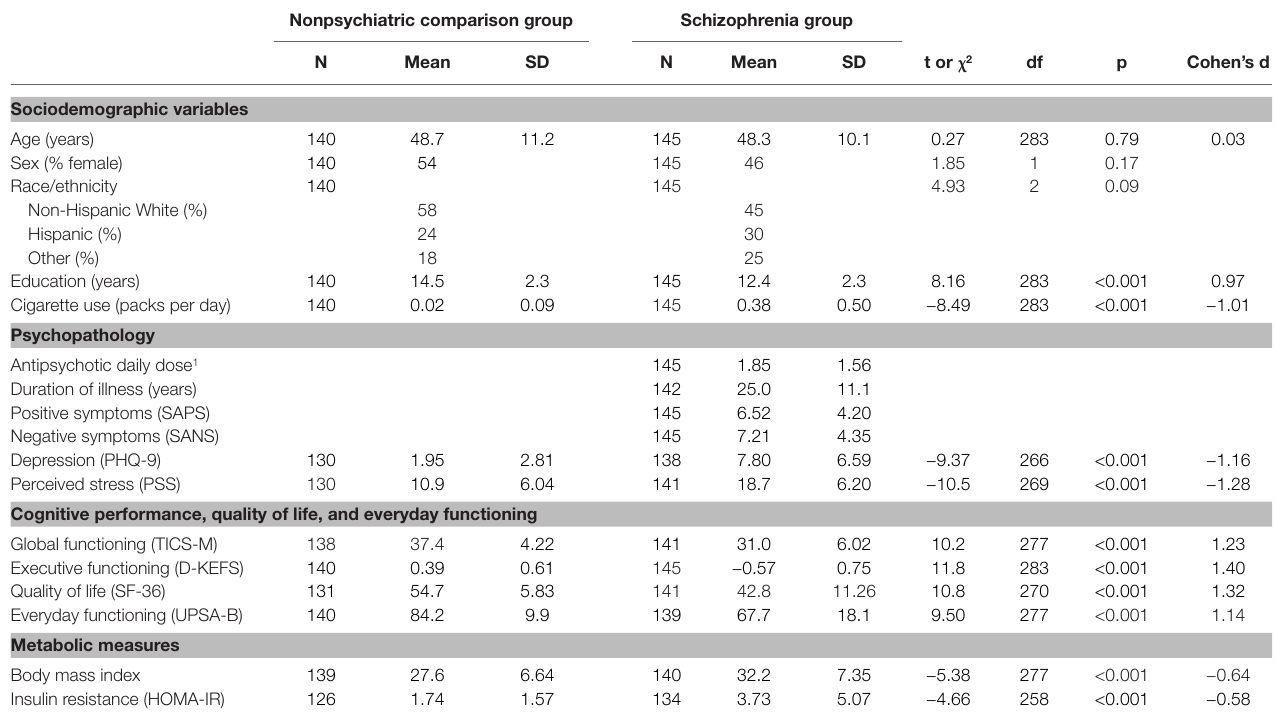
TABLE 1 | Comparison of study participants with and without schizophrenia. Nonpsychiatric comparison